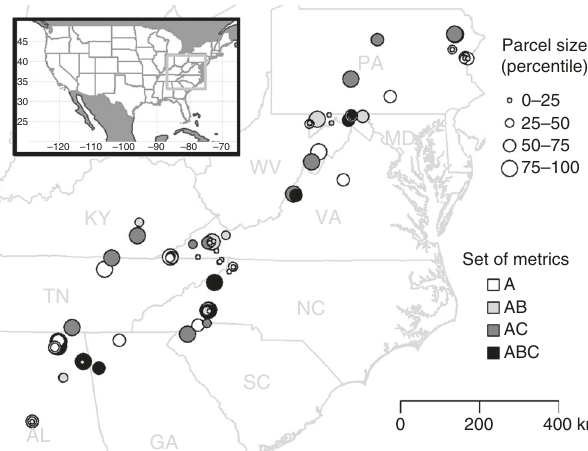
Fig. 4 Map of 96 parcels protected by The Nature Conservancy (TNC) used in this study. The size of circles roughly indicates parcel size categories (0 – 25 percentile: < 8.1 ha; 25 – 50 percentile: 8.1 – 27.2 ha; 50 – 75 percentile: 27.2 – 98.0 ha; 75 – 100 percentile: > 98.0 ha). Size categories are for illustration only — continuous area was used in analyses. Color coding indicates which ecological bene fi t metrics were available for each site. Five ecological bene fi t metrics were available for every parcel (set A), species of conservation concern are known to occur near 46 parcels (set B) and fi eld derived bene fi t metrics were based on a survey of 23 parcels (set